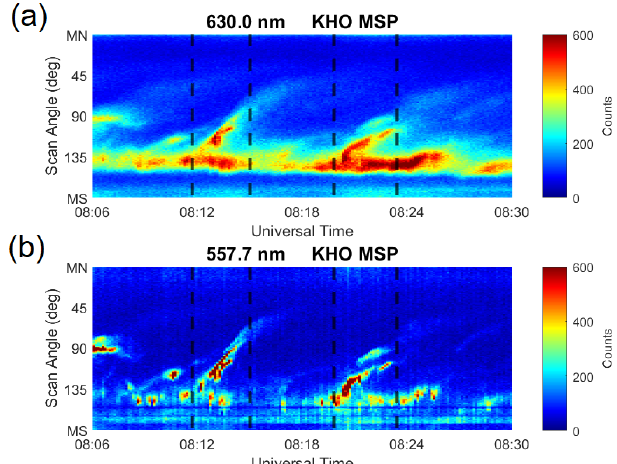
Figure 1. Uncalibrated keograms as a function of scan angle along the magnetic meridian from 0 ◦ (magnetic north, MN) to 180 ◦ (mag- netic south, MS) in the red (a) and green (b) auroral emission lines showing two PMAF events as well as their start and end times de- limited by dashed black lines. Time is displayed on the x axis as universal time, which lags behind magnetic local time (MLT) by approximately 3h in